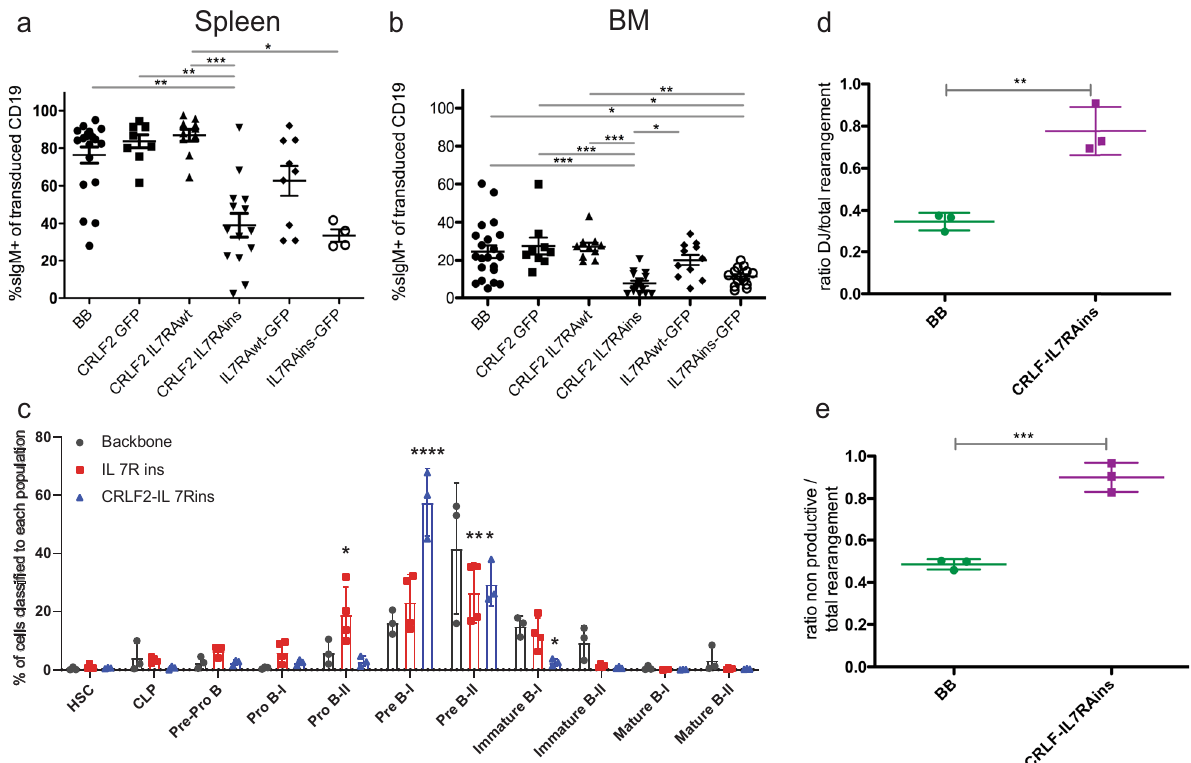
Fig. 1 CRLF2/IL7RA transduction alters B-lineage differentiation of human CB CD34 + progenitors transplanted in immune-de fi cient mice. a B-lineage differentiation to immature/naive B cells (sIgM + ) of human CB CD34 + cells from the spleen ( a ) and BM ( b ) of engrafted mice expressing GFP